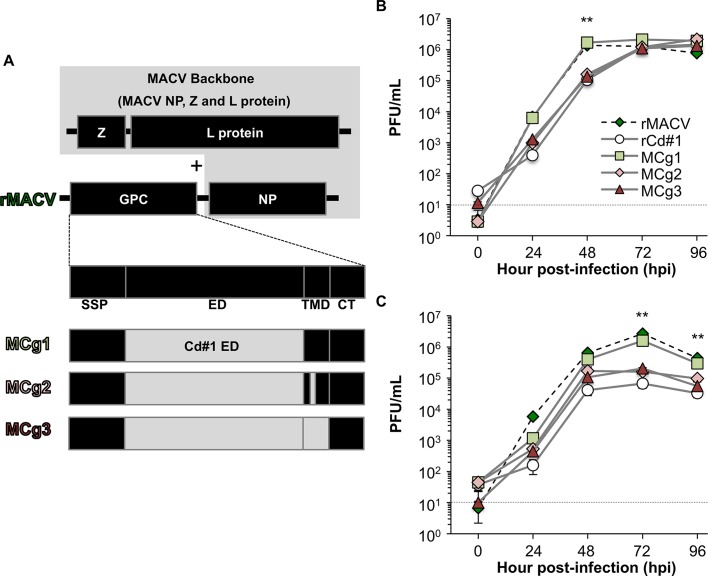
Schematic diagrams and the growth curve of MCg1, MCg2 and MCg3.(A) The ectodomain of GPC alone of rMACV was replaced by the Cd#1 counterpart in rMACV backbone (MCg1), ectodomain of rMACV was replaced by the Cd#1 GPC ectodomain with F427I TMD mutation (MCg2), and the ectodomain and TMD of rMACV GPC were replaced by those of Cd#1 GPC (MCg3). (B) Growth curve of the MCg1, MCg2 and MCg3 were determined in Vero cells (rMACV: N = 3, rCd#1: N = 4, MCg1-3: N = 7). The virus titer of MCg1 was significantly higher than those of rCd#1, MCg2 and MCg3 at 48 hpi in Vero cells (**, P<0.01, one-way ANOVA followed by Dunnett's test for MCg1 versus rCd#1, MCg1 versus MCg2 and MCg1 versus MCg3). (C) Growth curve of the MCg1, MCg2 and MCg3 were determined in A549 cells (rMACV: N = 3, rCd#1: N = 4, MCg1-3: N = 6). The virus titer of MCg1 was significantly higher than those of rCd#1, MCg2 and MCg3 at 72 hpi and 96 hpi in A549 cells (**, P<0.01, one-way ANOVA followed by Dunnett's test for MCg1 versus rCd#1, MCg1 versus MCg2 and MCg1 versus MCg3). The dashed lines indicate the detection limit. The data of rCd#1 in the Fig 1B and 1C has been published in Fig 1B and 1C respectively, of [16].